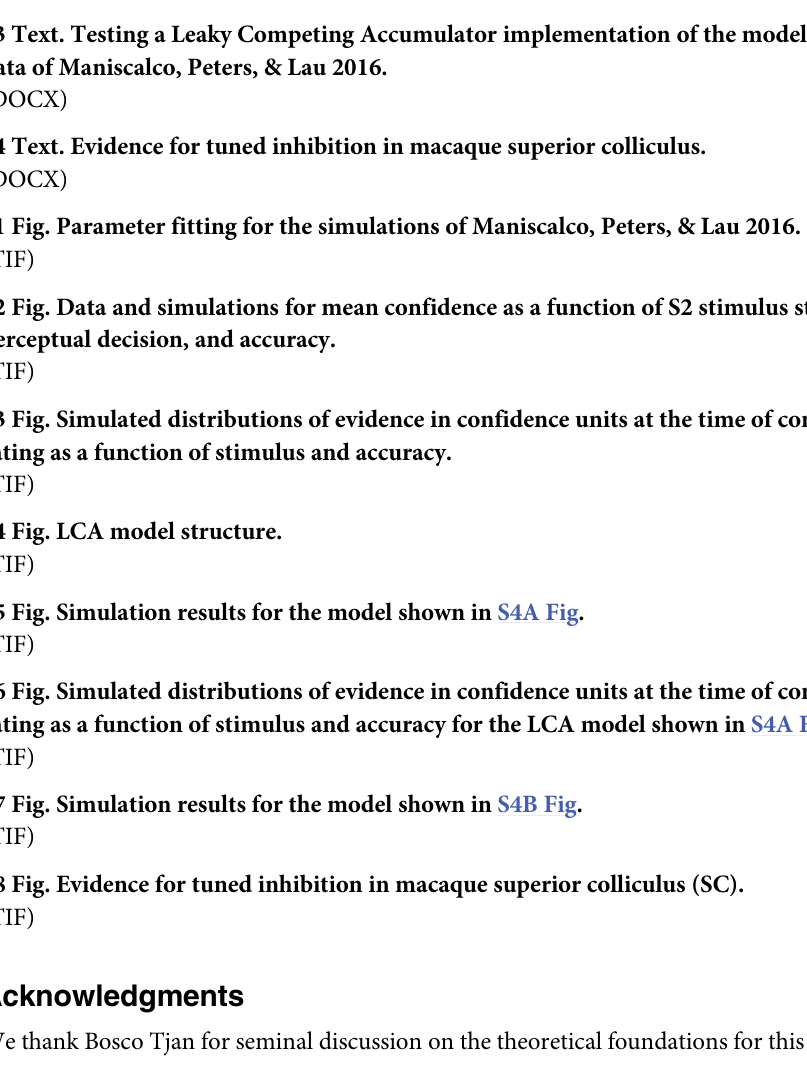
S1 Fig. Parameter fitting for the simulations of Maniscalco, Peters, & Lau 2016. S2 Fig. Data and simulations for mean confidence as a function of S2 stimulus strength, perceptual decision, and accuracy. S3 Fig. Simulated distributions of evidence in confidence units at the time of confidence rating as a function of stimulus and accuracy.